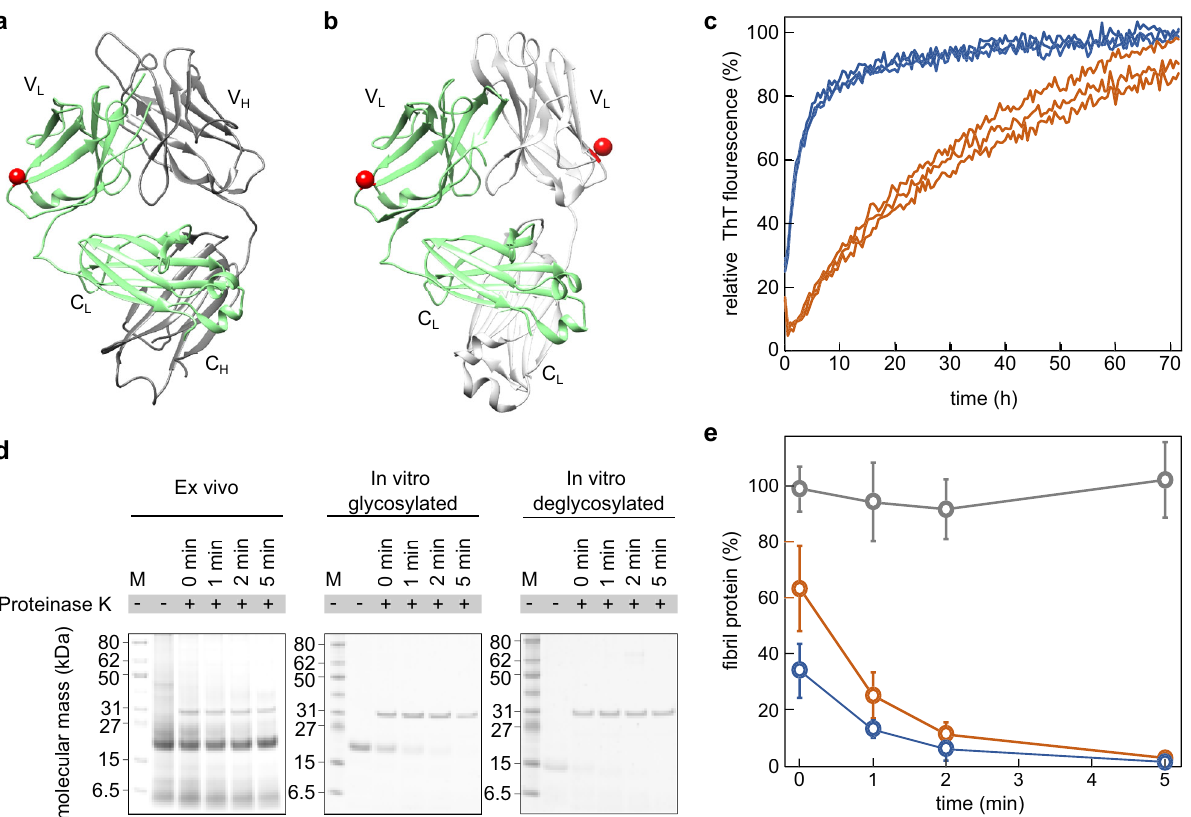
Fig. 5 Effect of glycosylation on the formation of fi brils from FOR001 fi bril protein. a Ribbon representations of a fragment antigen binding that contains a LC with an IGLV1-51*02 GL segment (PDB 4ODH 10.2210/pdb4ODH/pdb). The V L and the C L domain, as well as the variable heavy (V H ) and constant heavy (C H ) domains are labeled. The LC is marked green, the heavy chain is displayed in gray. Red sphere: residue homologous to the FOR001 glycosylation site. b Crystal structure of a LC dimer encompassing an IGLV1-51*02 GL segment (PDB 5MUD 10.2210/pdb5MUD/pdb). One LC in the dimer is marked green, the other in gray. Red sphere: as in ( a ). c Fibril-formation kinetics of refolded FOR001 fi bril protein as obtained from real-time measurements of the ThT fl uorescence intensity. Blue: deglycosylated; red: glycosylated protein. d Coomassie-stained denaturing-protein electrophoresis gels of samples to estimate the proteolytic stability of ex vivo FOR001 fi brils and fi brils formed in vitro from deglycosylated and glycosylated FOR001 protein. Each gel was replicated three times. M: marker. e Densitometric quanti fi cation of the fi bril protein band ( n = 3) of ex vivo fi brils (gray) and in vitro fi brils from deglycosylated (blue) and glycosylated FOR001 protein (red) after digestion with proteinase K for different periods of time. The band intensity of the sample before proteinase K addition was set to 100%. Based on a one-tailed Welch t -test, the amounts of glycosylated and deglycoslated fi bril proteins differ from one another with a p-value of 0.032 and 0.049 at time points 0 min and 1 min, respectively. Error bars represent the standard